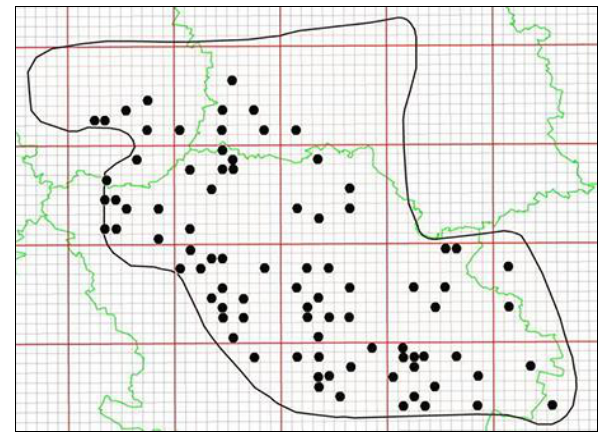
Fig. 6. The distribution of Helianthus annuus var. macrocarpus (DC.) Cockerell in the Romensko-Poltavsky Geobotanical District